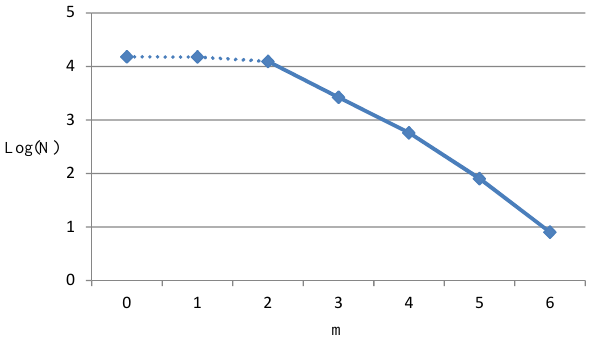
Fig. 2. Gutenberg–Richter plot for the Azores region showing all Figure 2. Gutenberg-Richter plot for the Azores region showing all catalog seismicity. 3 catalog 4